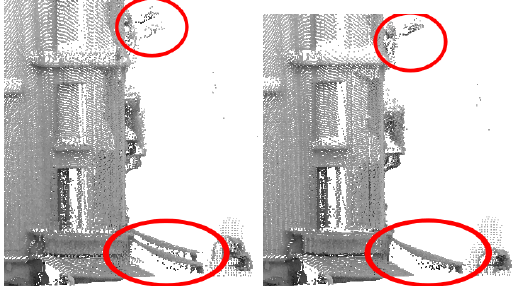
Figure 12: Illustration of the proposed ICP optimal variant for the MMS dataset. Left: before registration. Right: after registration, colored using ambient occlusion.